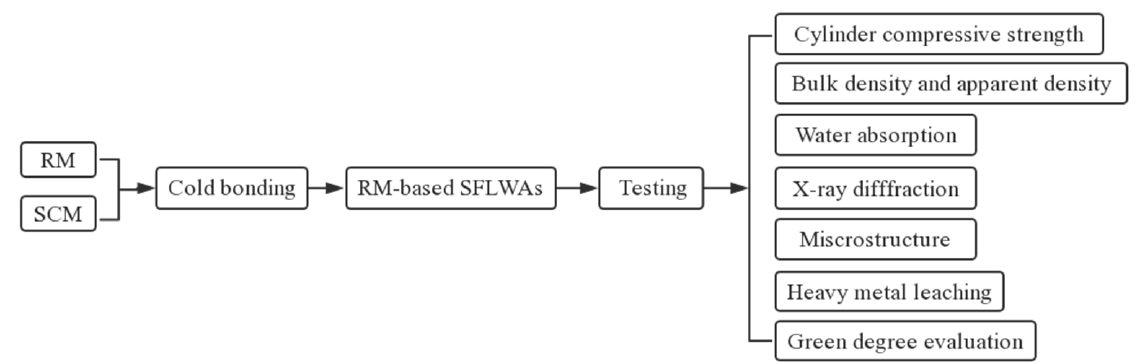
Figure 4. The experimental program of RM-based SFLAs.